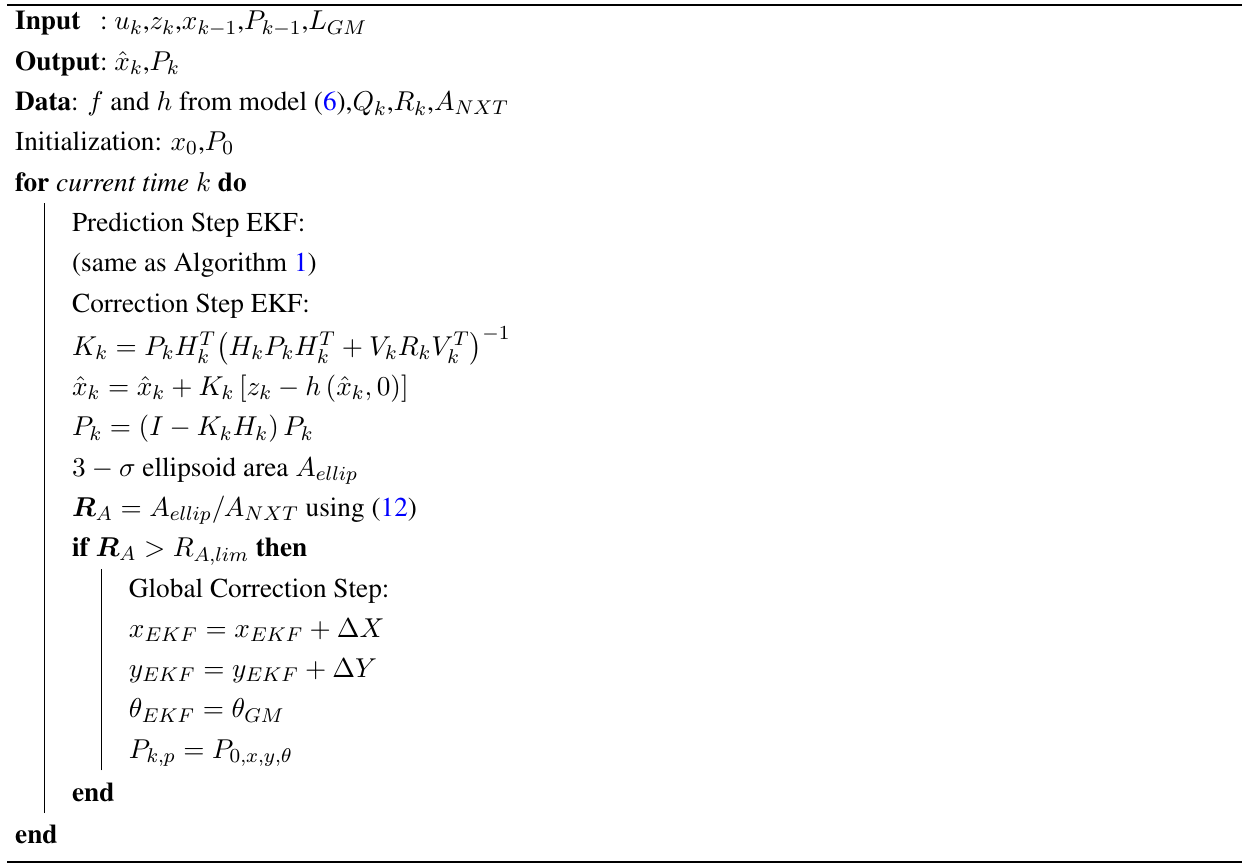
Algorithm 4: Recursive EKF algorithm with event based